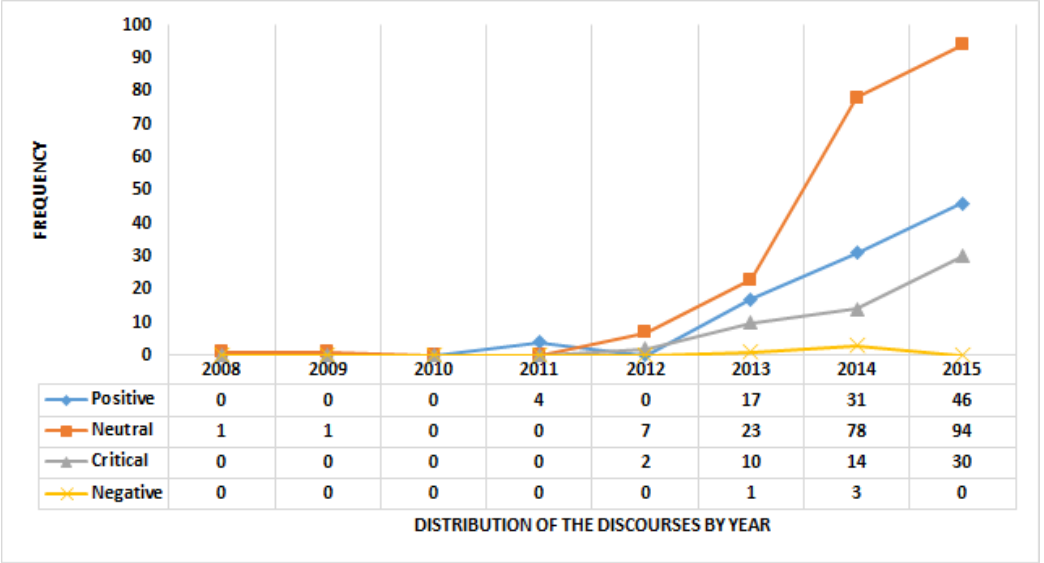
Figure 4. Distribution of discourse in MOOC articles by